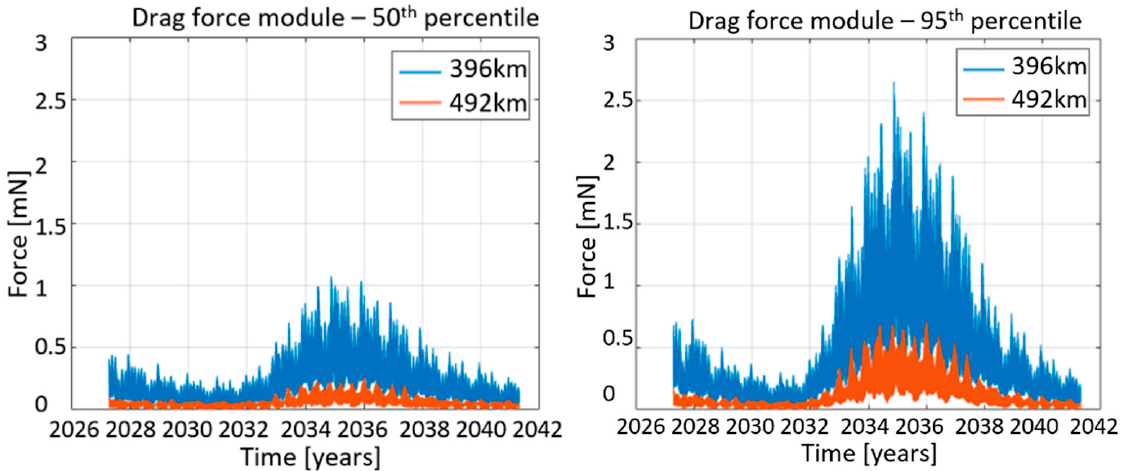
Figure 14. Drag force module over 14 years from 2027 at 396 km and 492 km altitude, computed with 50th percentile ( left ) and 95th percentile ( right ) on F 10.7 and A p prediction. According to the predicted activity in solar cycle 26, the maximum is expected to occur around October 2034; the date comprised in the planned NGGM on-orbit lifetime. The three components of the uncompensated drag accelerations experienced by the satellite (expressed in its reference frame), computed along two orbits at the maximum of the predicted solar activity with the 95th percentile, are provided in Figure 15 (time series) and Figure 16 (amplitude spectral density).